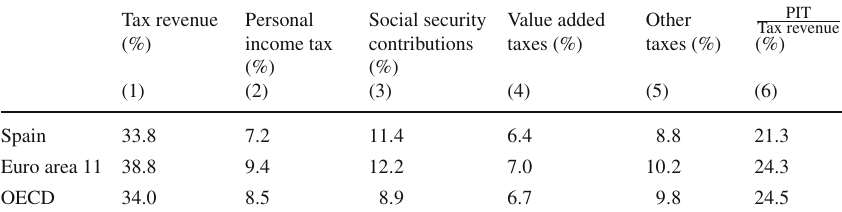
Table1 Distribution of tax revenues in 2015 (% of GDP). Source: OECD tax statistics (https://doi.org/10. 1787/data-00262-en) Tax revenue